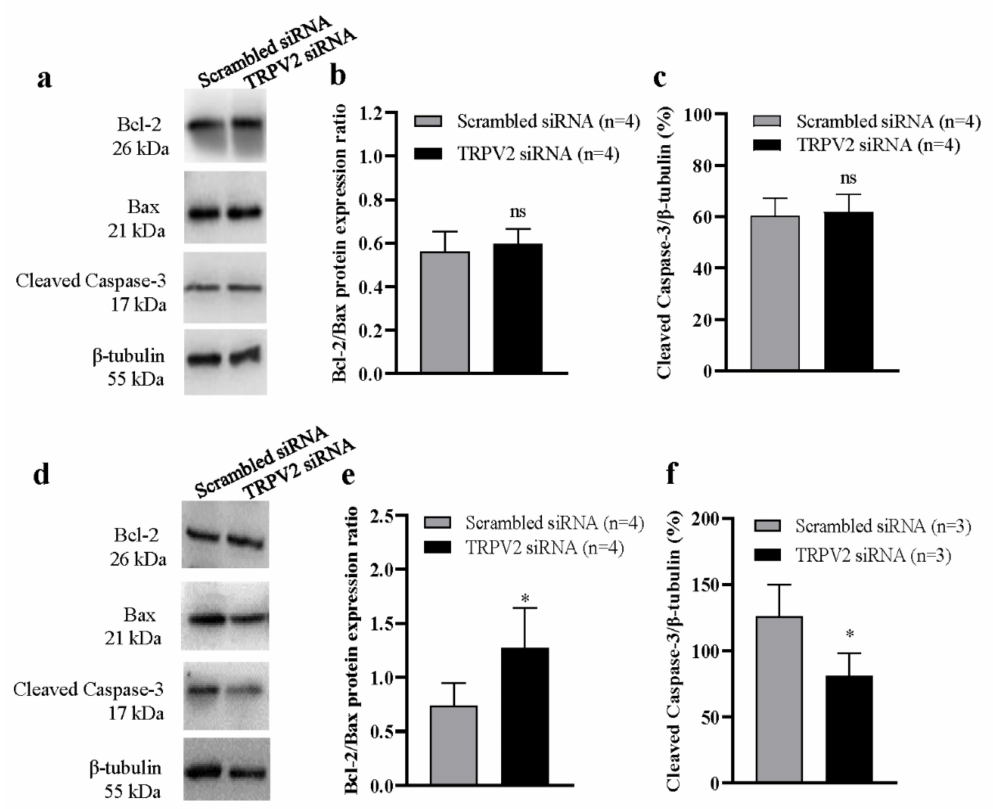
Figure 4. Role of TRPV2 in high glucose–induced apoptosis of lens epithelial cells. Representative Western blotting images ( a , d ) and summary data ( b , c , e , f ) showing Bcl-2/Bax protein expression ratios and the levels of active caspase-3 in HLEpiCs cultured in a normal-glucose (( a – c ), 5.5 mM glucose and 20 mM mannitol) or high-glucose (( e , f ), 25.6 mM glucose) medium for seven days and transfected with TRPV2 siRNA or scrambled siRNA control. Values are shown as the mean ± SEM; n = 3–4. * p < 0.05 vs. scrambled siRNA analyzed by two-tailed unpaired Student’s t test; ns, not